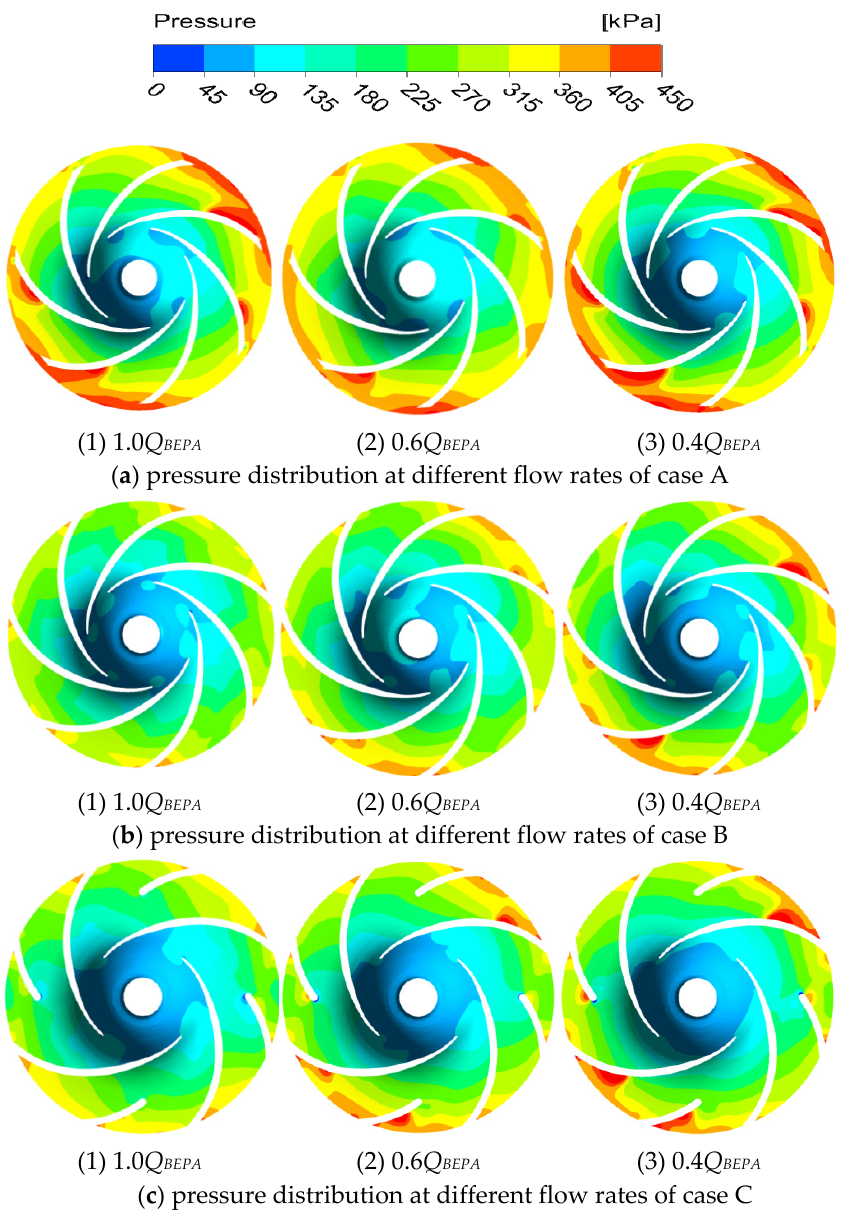
Figure 10. pressure distribution of impeller under different flow rates. Figure 10. Pressure distribution of impeller under different flow